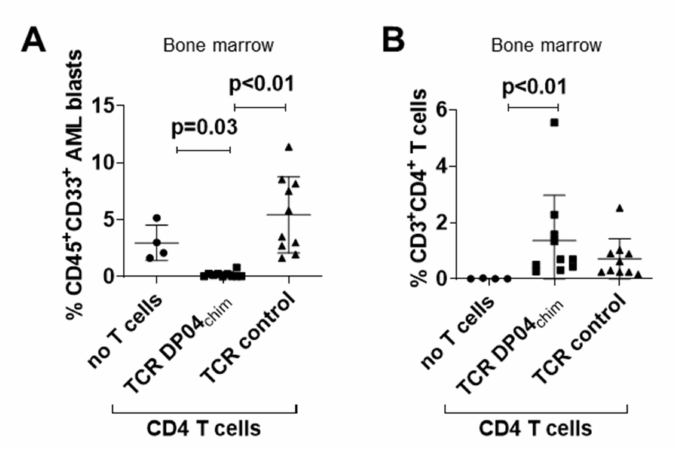
Figure 2. Anti-leukemic activity of TCR DP04 chim modified CD4 T cells in AML-engrafted NSG mice. Sublethally irradiated (1.5 Gy) NSG mice were intravenously injected with 4 × 10 6 primary blasts of AML167 (HLA-DPB1*04:01 / 17:01). On day 21, when leukemia engraftment reached a level of 1%–5% in bone marrow as confirmed in identically treated control mice, 1 × 10 7 CD4 T cells retrovirally transduced with TCR DP04 chim ( n = 10) or a control TCR (CMVpp65 / HLA-A*02:01-specific; n = 10) were intravenously injected along with single doses of rh IL-2 (1000 IU) and FcIL-7 (20 µ g). Animals in the control group without T cells ( n = 4) only received rh IL-2 and Fc-IL-7. On day 28 (i.e., seven days after T cell transfer), ( A ) AML burden (CD45 + CD33 + cells) and ( B ) T cell frequencies (CD3 + CD4 + cells) were analyzed in bone marrow. Results are pooled from two independent experiments. Symbols represent individual mice and horizontal bars mark mean values with standard deviation. p -values were calculated by Kruskal–Wallis test with Dunn’s correction for multiple comparisons, p < 0.05 considered